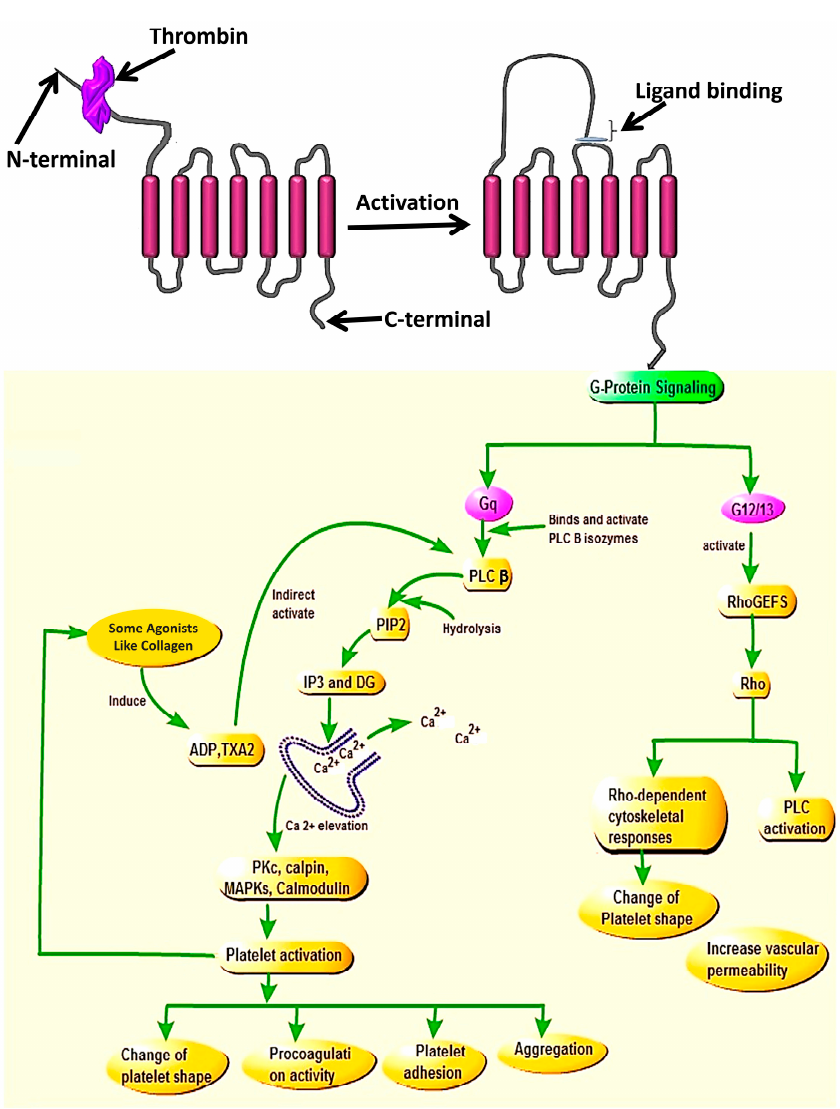
Figure 2. PAR4 signaling mechanism via Gq or G12/13 family members after cleavage of receptor.